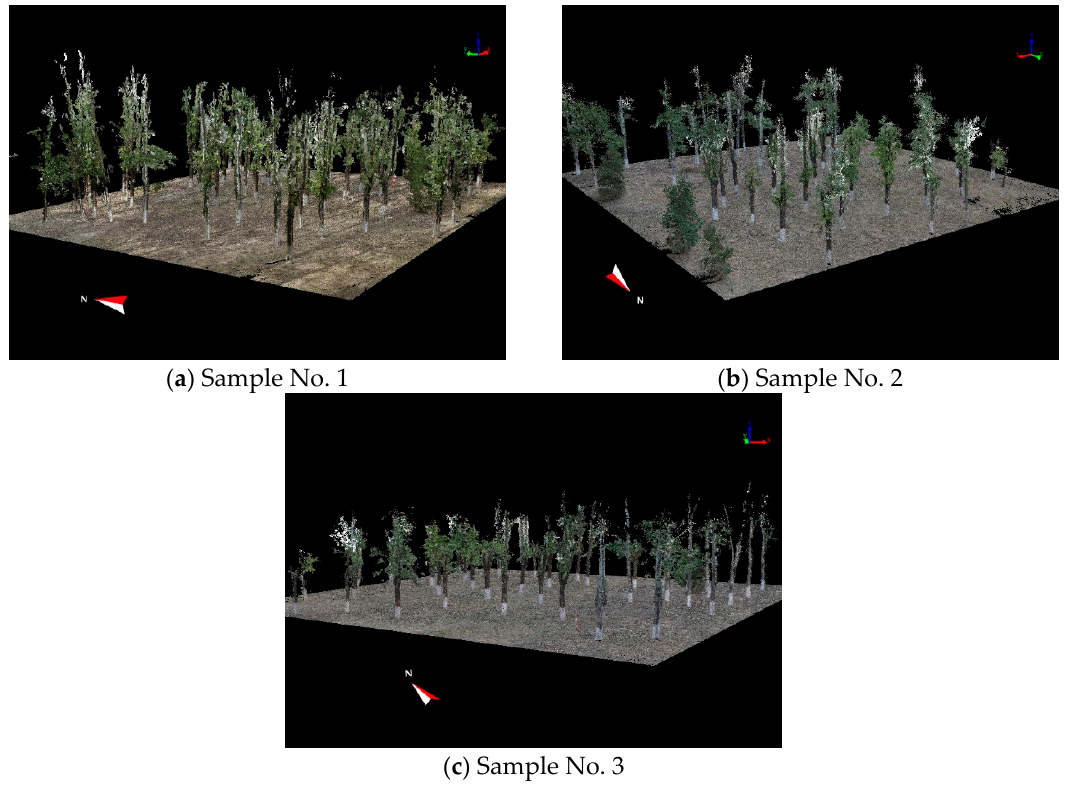
Figure 6. Detailed 3D view of the point cloud from CTP. ( a ), ( b ), and ( c ) show the 3D point cloud renderings established by CTP of plots 1, 2, and 3, respectively.